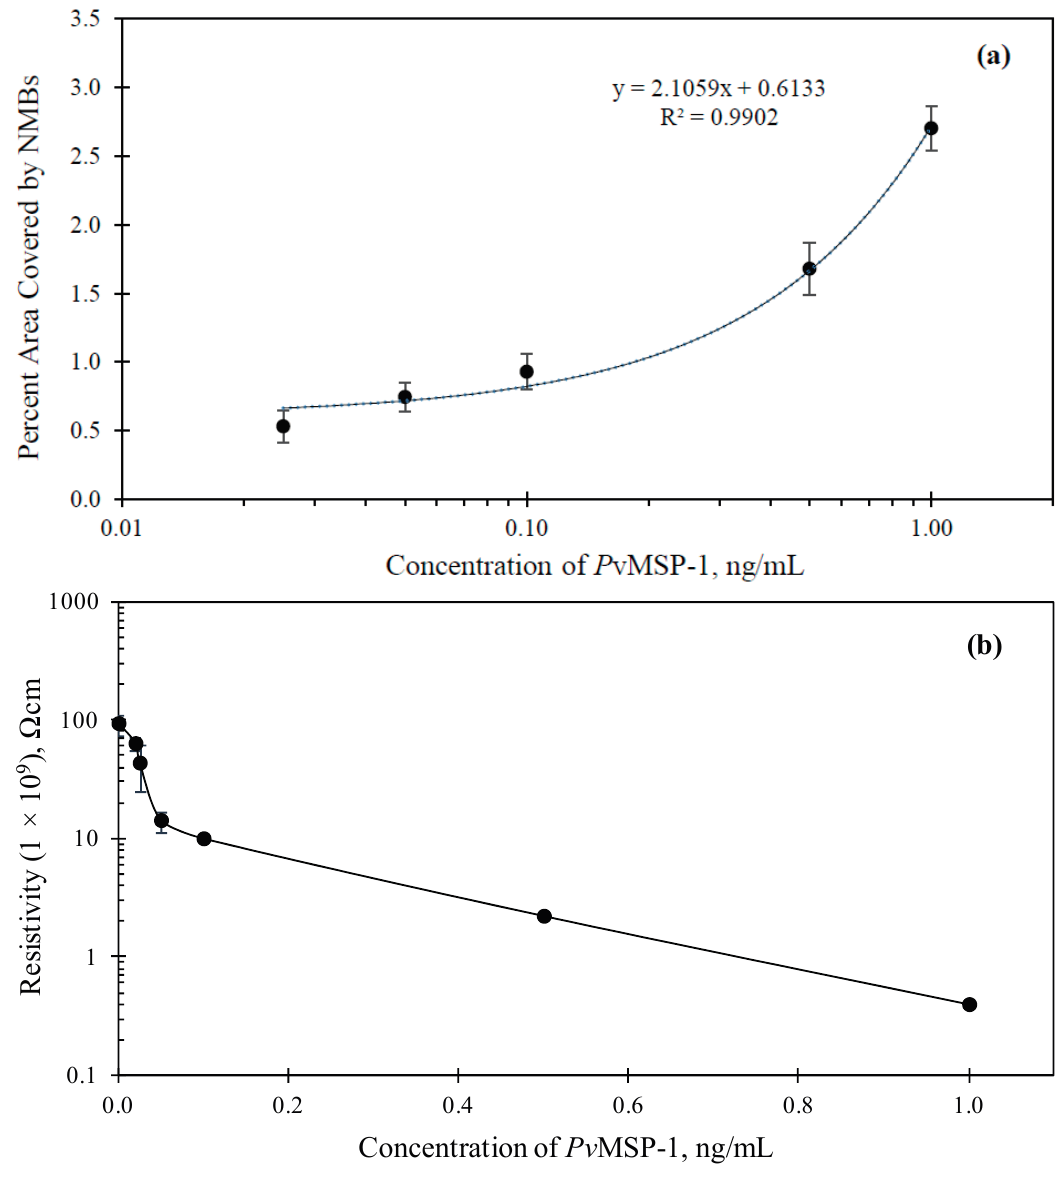
Figure 6. ( a ) Variation of percent area of the capture zone covered with NMBs against Pf MSP-1 concentrations and ( b ) Variation of the resistivity of the capture zone with the concentration of immobilized Pf MSP-1. The error bars in both graphs are also